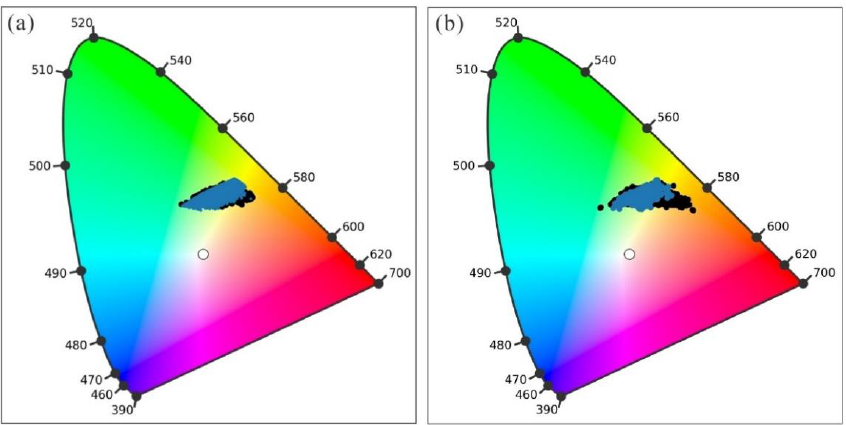
Figure 12. The chromaticity coordinates of reflectance at each inundated pixel (shallow water and deep water) for Tauranga Harbour before (black) and after (blue) correction using the temporal (monthly) ( a , b ) spatial method (60 m) has been applied. The selected Sentinel-2 image(s) were the same set as used in Figures 9 and 11.